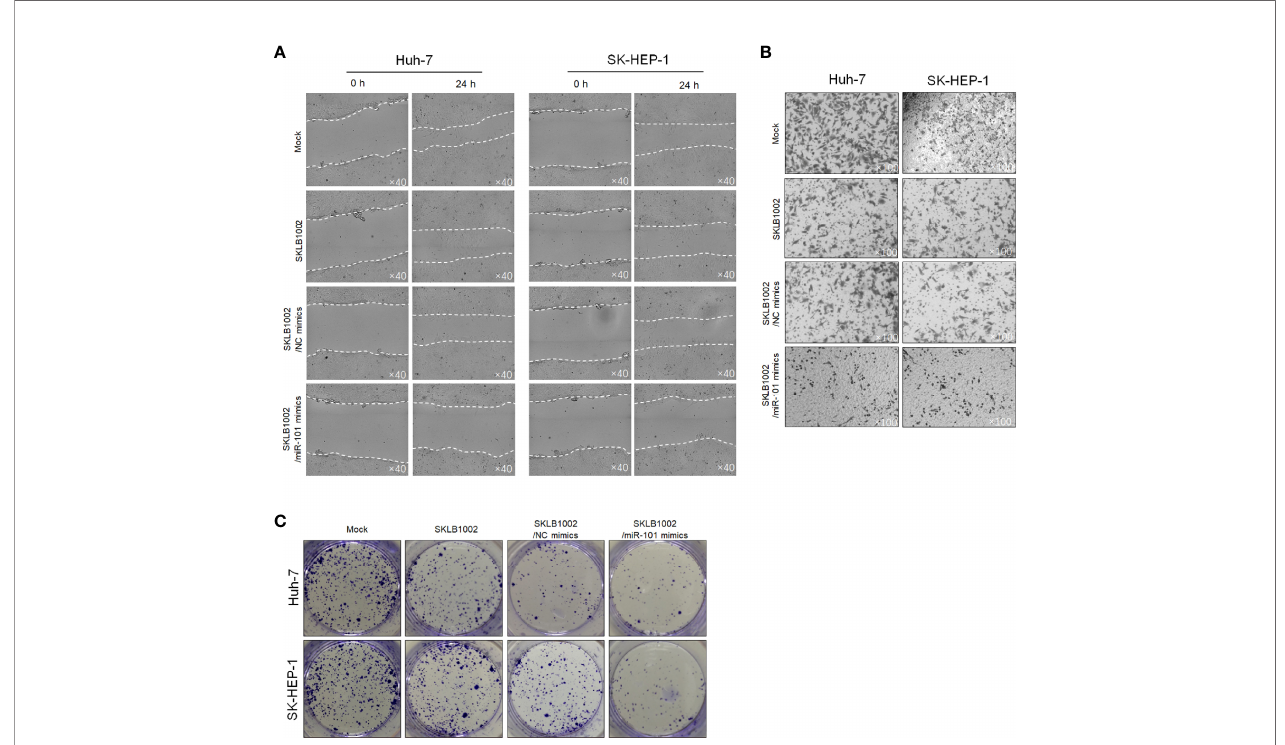
FIGURE 9 | CCDC88A regulates malignant behaviors in Huh-7 and SK-HEP-1 cells partially via regulating VEGFA. After the addition of SKLB1002, a VEGFR2 inhibitor, transfected miR-101 mimics further inhibited malignant behaviors including migration (A) , invasion (B) , and colony formation (C) .